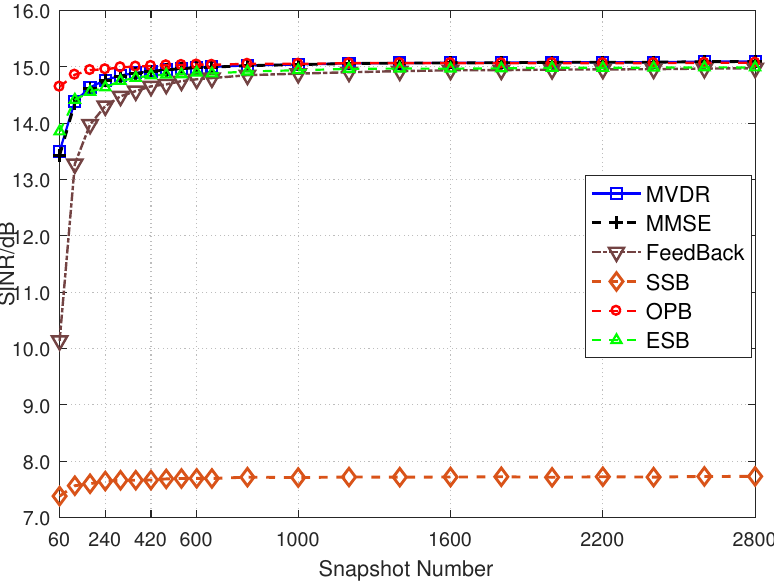
Figure 3. Output SINR versus the number of snapshots. Example 2. The output SINR versus with the number of